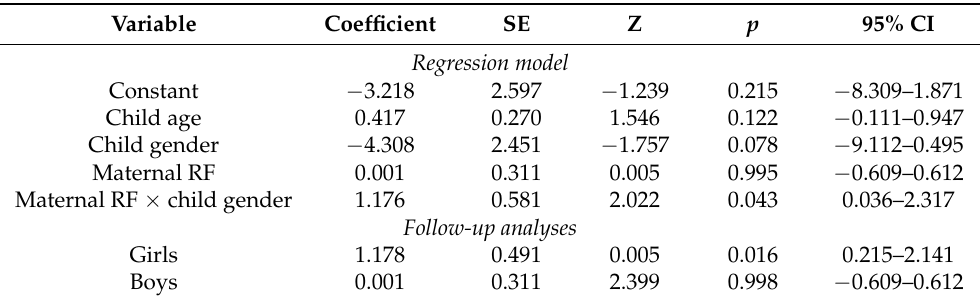
Table 3. Regression and follow-up analyses predicting child attachment classification (secure